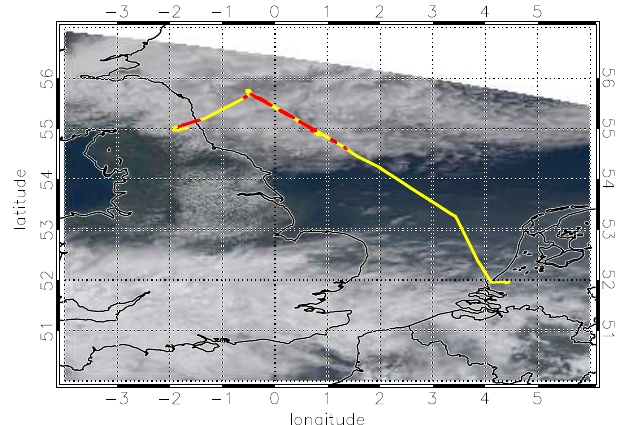
Fig. 1. Image from the Moderate Resolution Imaging Spectrora- diometer (MODIS) system (Terra satellite, 11:15UTC). Yellow line shows the trajectory of the ATR-42 morning flight on 15 May. Red segments indicate periods where aircraft encountered a